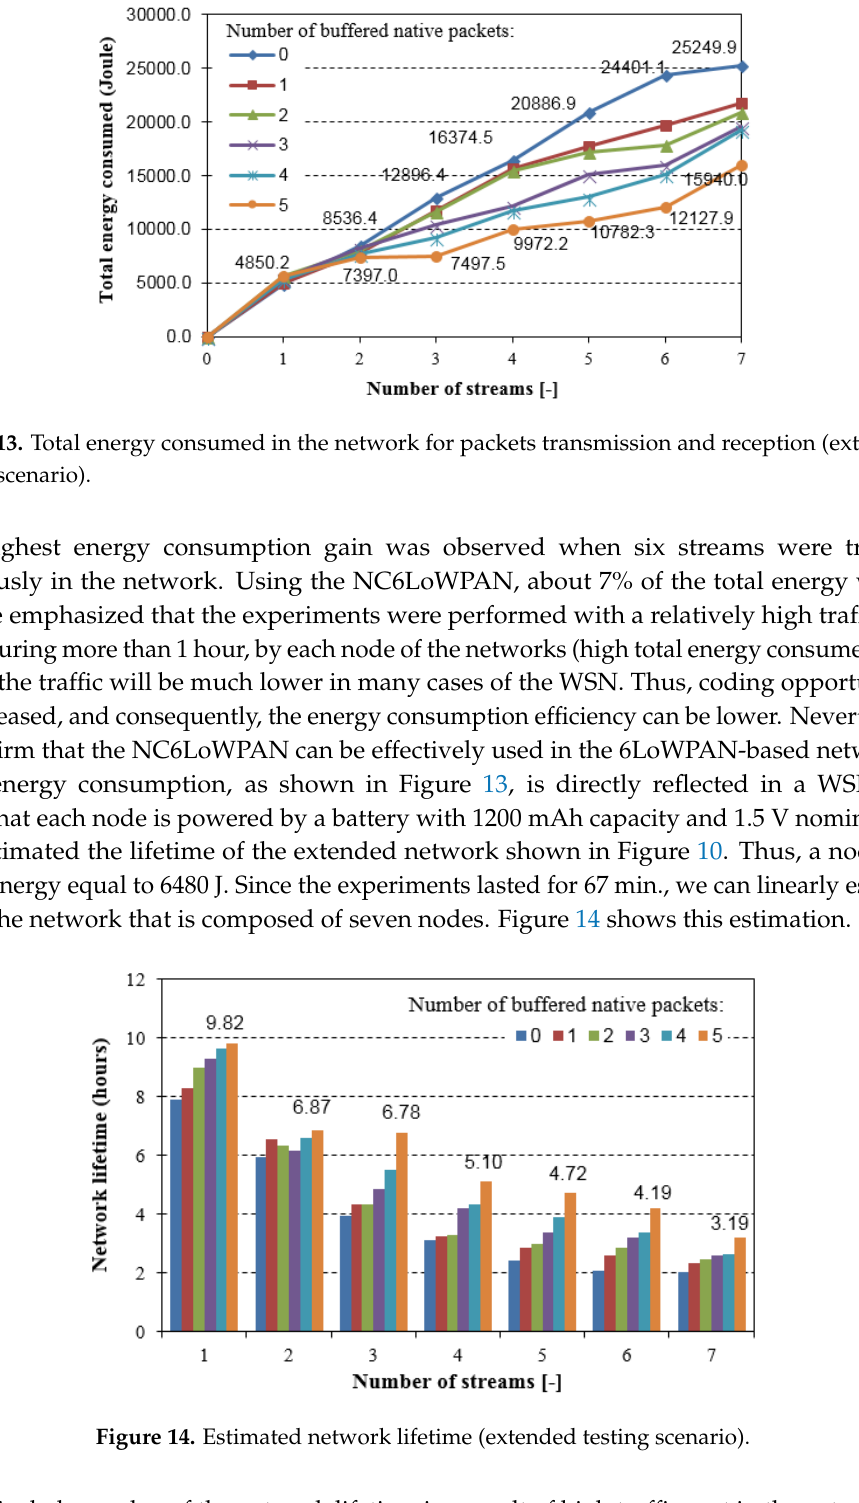
Figure 14. Estimated network lifetime (extended testing scenario).